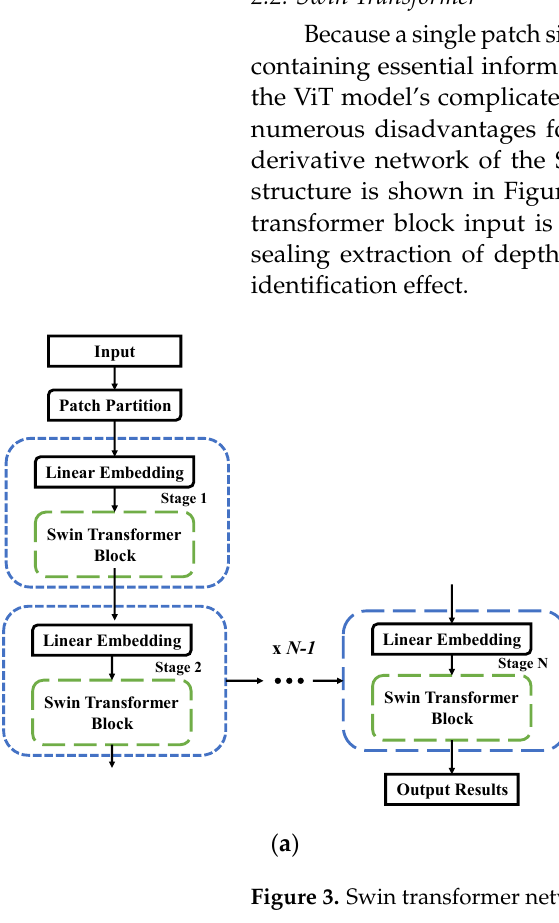
𝐻 × W × 𝑊 , with the Swin trans- , with the Swin C C 𝐶 𝐶